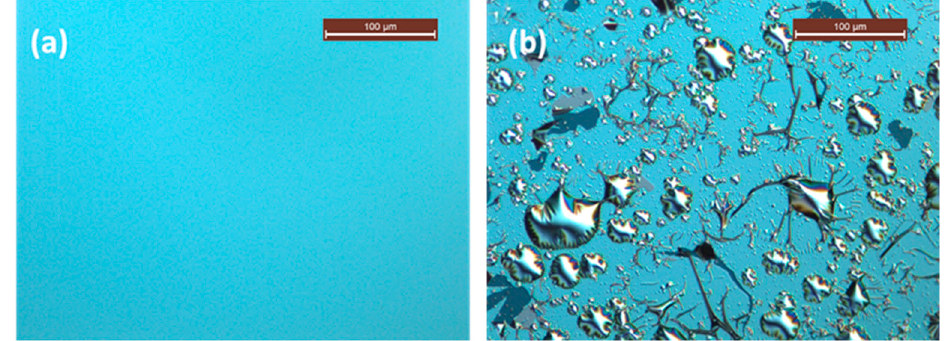
Figure 3. Optical microscope image for the two samples: ( a ) sample S1 stored at 10% humidity and ( b ) sample S2 stored at 50% humidity.